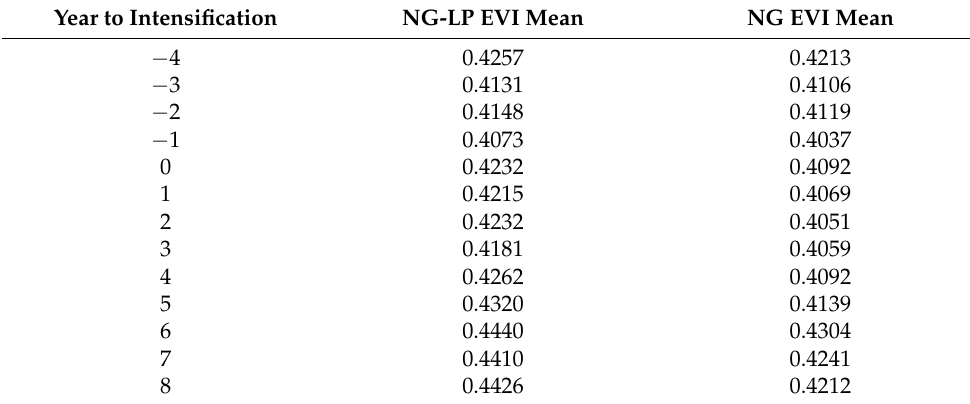
Table A4. Interannual EVI mean for Treatment × Year to intensification.